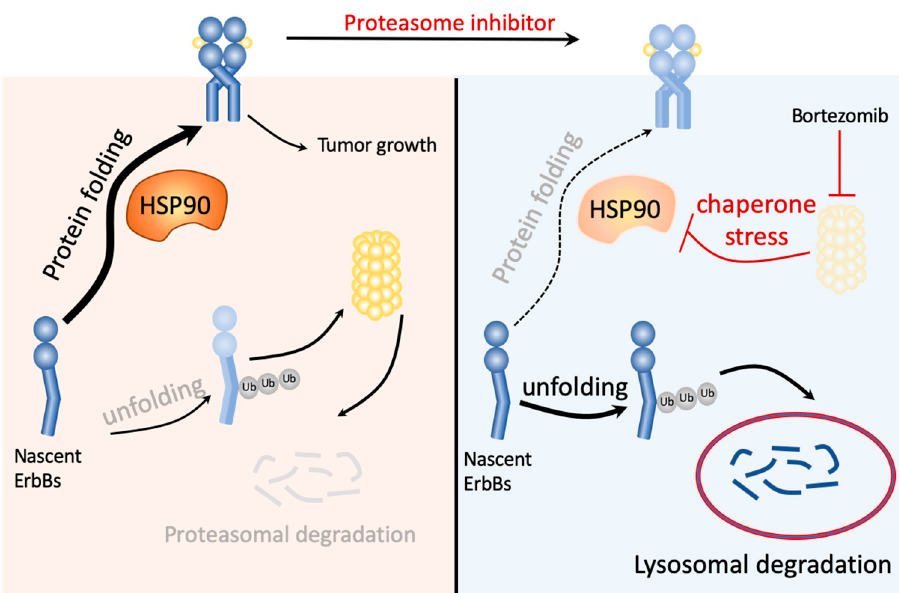
Figure 8. Hypothesis model of ErbB family degradation pathways in response to proteasome inhibitor bortezomib. The unfolding proteins are commonly degraded via the ubiquitin-proteasome pathway. However, the reversible inhibitor of the 26S proteasome, bortezomib, blocked the activity of proteasome, leading to HSP90 inhibition through chaperone stress response. The unfolding proteins remain ubiquitinated and were degraded through the lysosome instead of the proteasome.